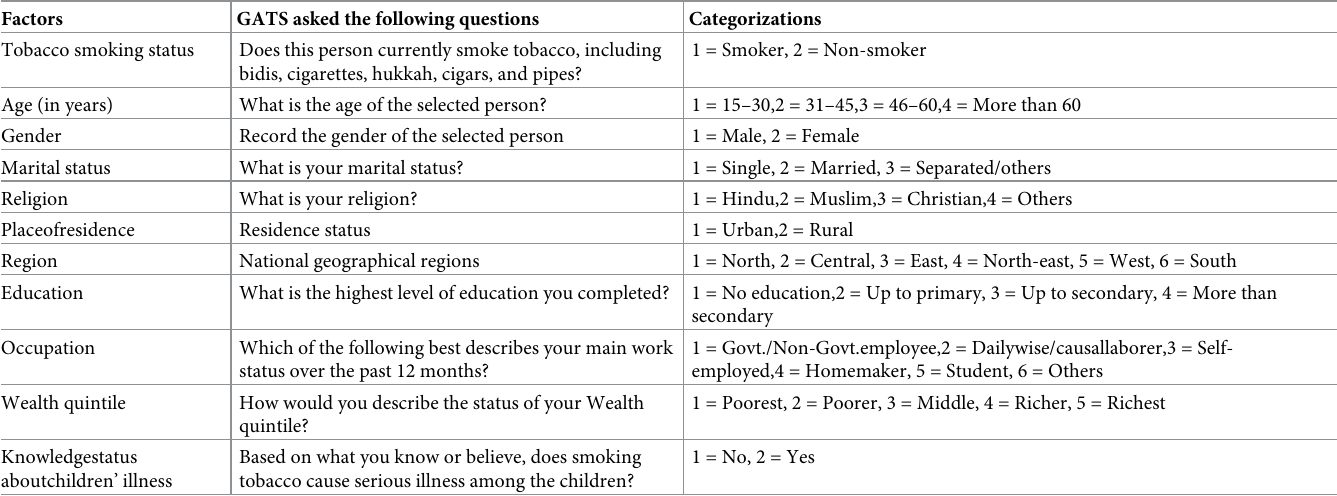
Table 1. Descriptions of the independent variables along with their